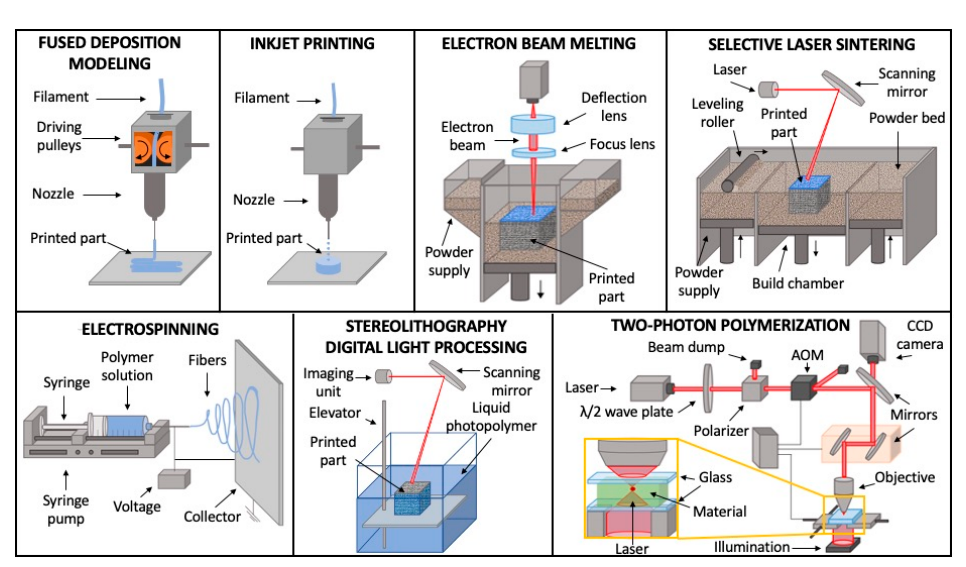
Figure 3. Schematic illustrations of the most diffused 3D printing fabrication techniques for porous scaffolds manufacturing: fused deposition modeling, inkjet printing, electron beam melting, selective laser sintering, stereolithography, electrospinning, two-photon